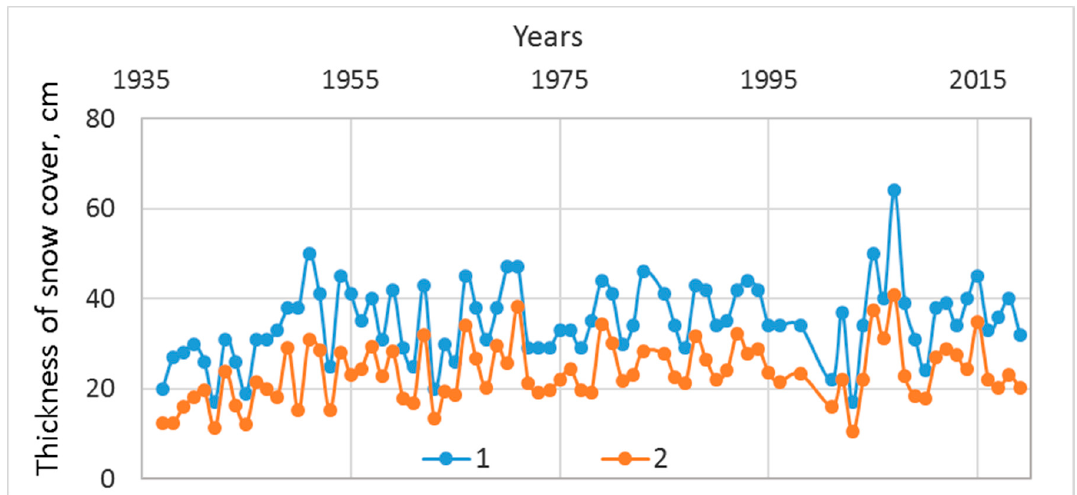
Figure 12. Dynamics of the maximum and mean depth of snow cover by surveys of snow cover (weather station Churapcha). 1—maximum thickness of the snow cover; 2—average thickness of the snow cover during the winter.